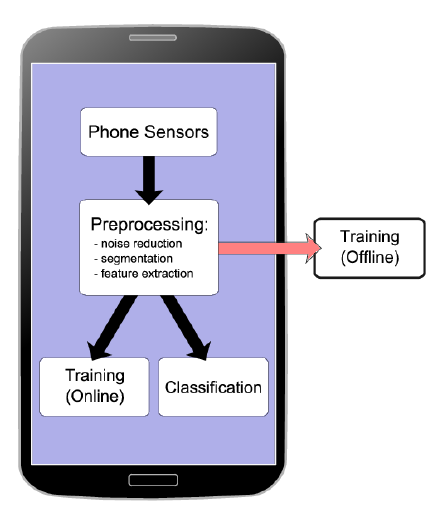
Figure 1. Activity recognition steps.